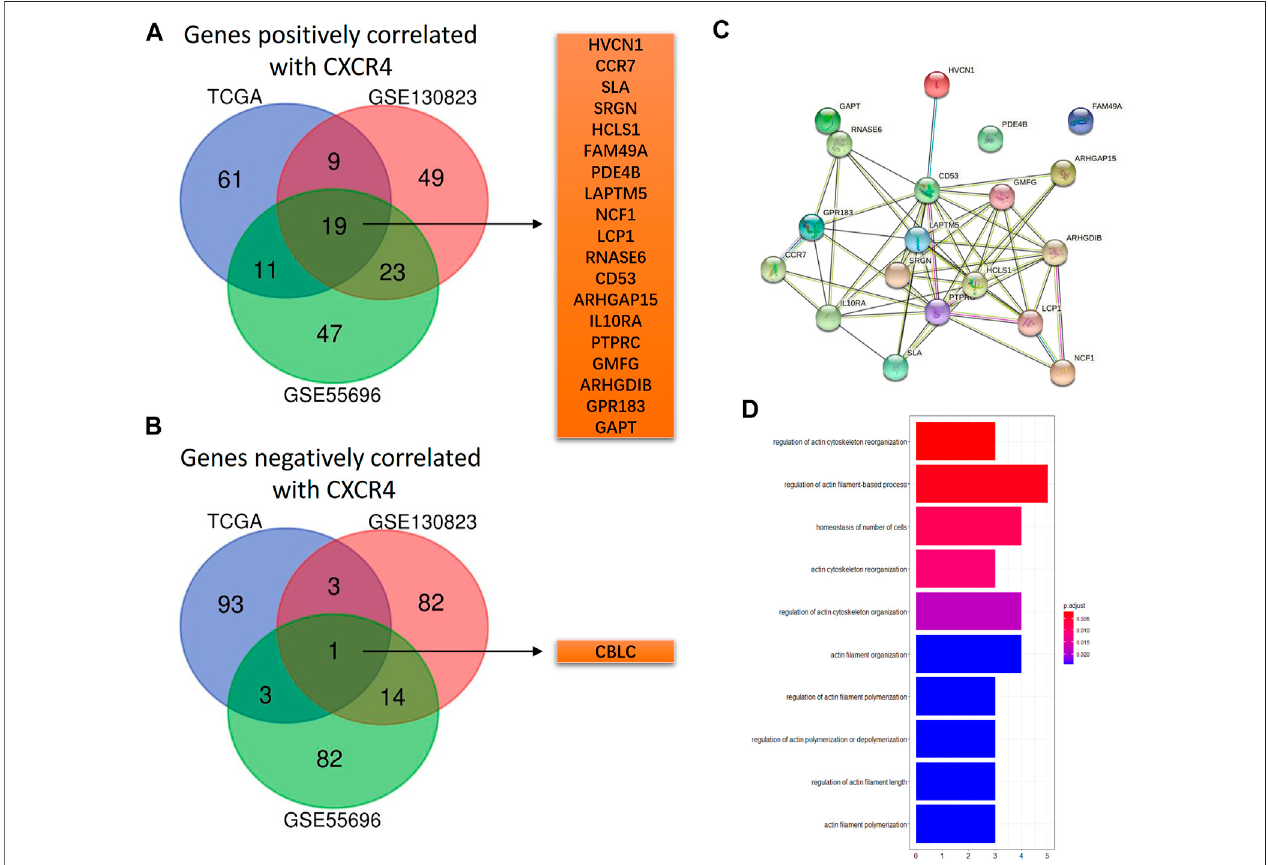
FIGURE4| CXCR4co-expressiongenes. (A) Venndiagramshowing19sharedgenespositivelycorrelatedwithCXCR4fromGSE55696,GSE130823,andTCGA cohorts. (B) Venn diagram showing one shared gene negatively correlated with CXCR4 from GSE55696, GSE130823, and TCGA cohorts. (C) PPI network of the 19 genes positively correlated with CXCR4. (D) Results of GO enrichment of the 19 genes positively correlated with CXCR4.